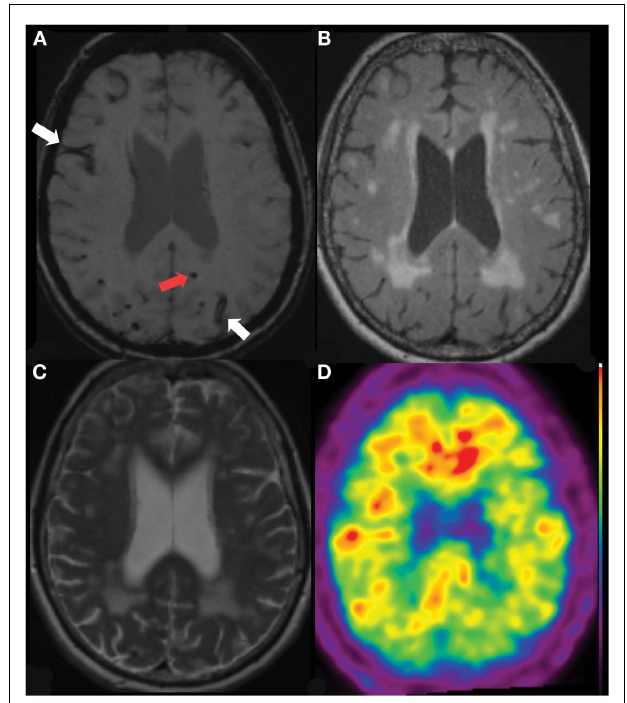
FIGURE 2 | Lobar Microbleed (red arrow) and Superficial Hemosiderosis (white arrows) in a 66-year-old lady referred initially with amnestic MCI (MMSE 22/30, CDR 0.5, CDR-SOB 4.5), subsequently diagnosed withAD-type dementia . SWI image (A) , with coregistered FLAIR (B) ,T2 (C) and 11C-PiB PET (D) images demonstrating severe deep white matter hyperintensities with elevated beta-amyloid burden (neocortical SUVR =